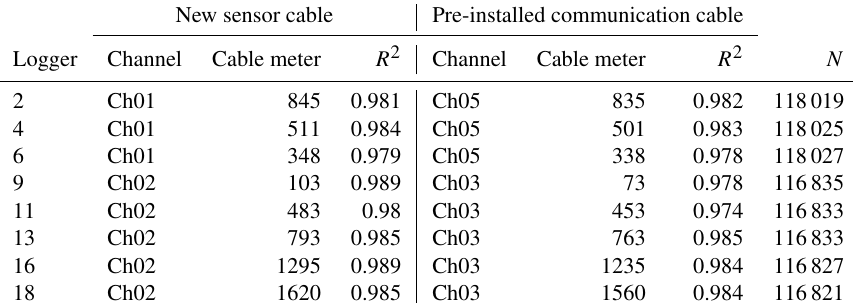
Table 2. Correlations among stand-alone data loggers.